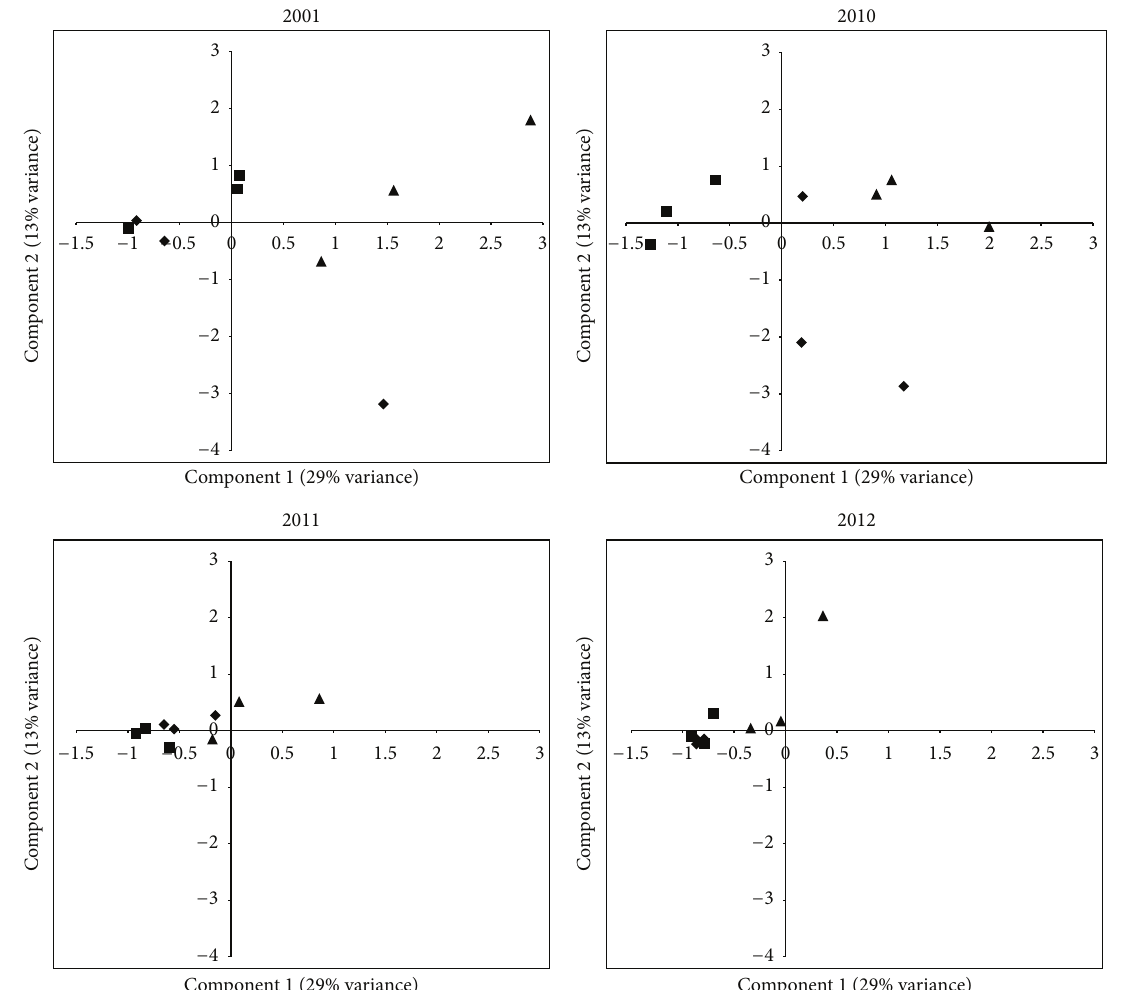
Figure 2: Principal component analysis of SSCP fingerprints from Stone’s Pocket. Symbols indicate 󳵳 plot L, ◼ plot I, and ⧫ plot J.